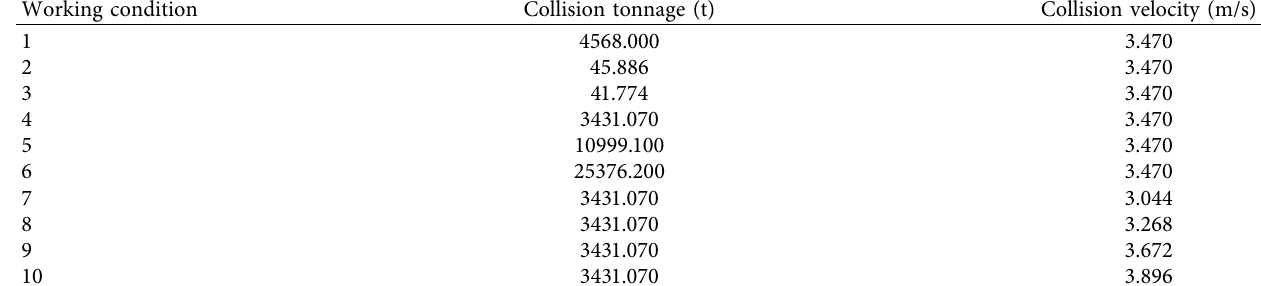
Table 4: The correspondence between tonnage sample and collision velocity sample.